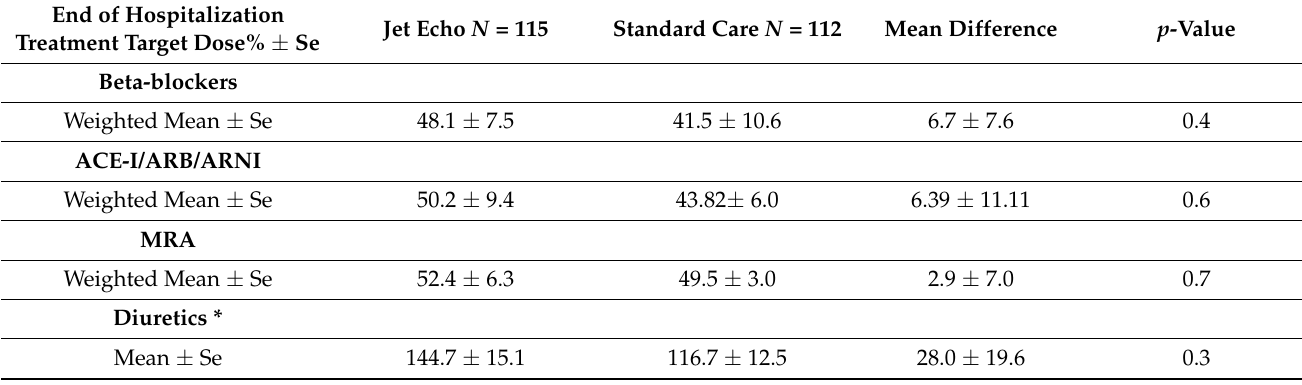
Table A1. Hospitalization discharge treatment.